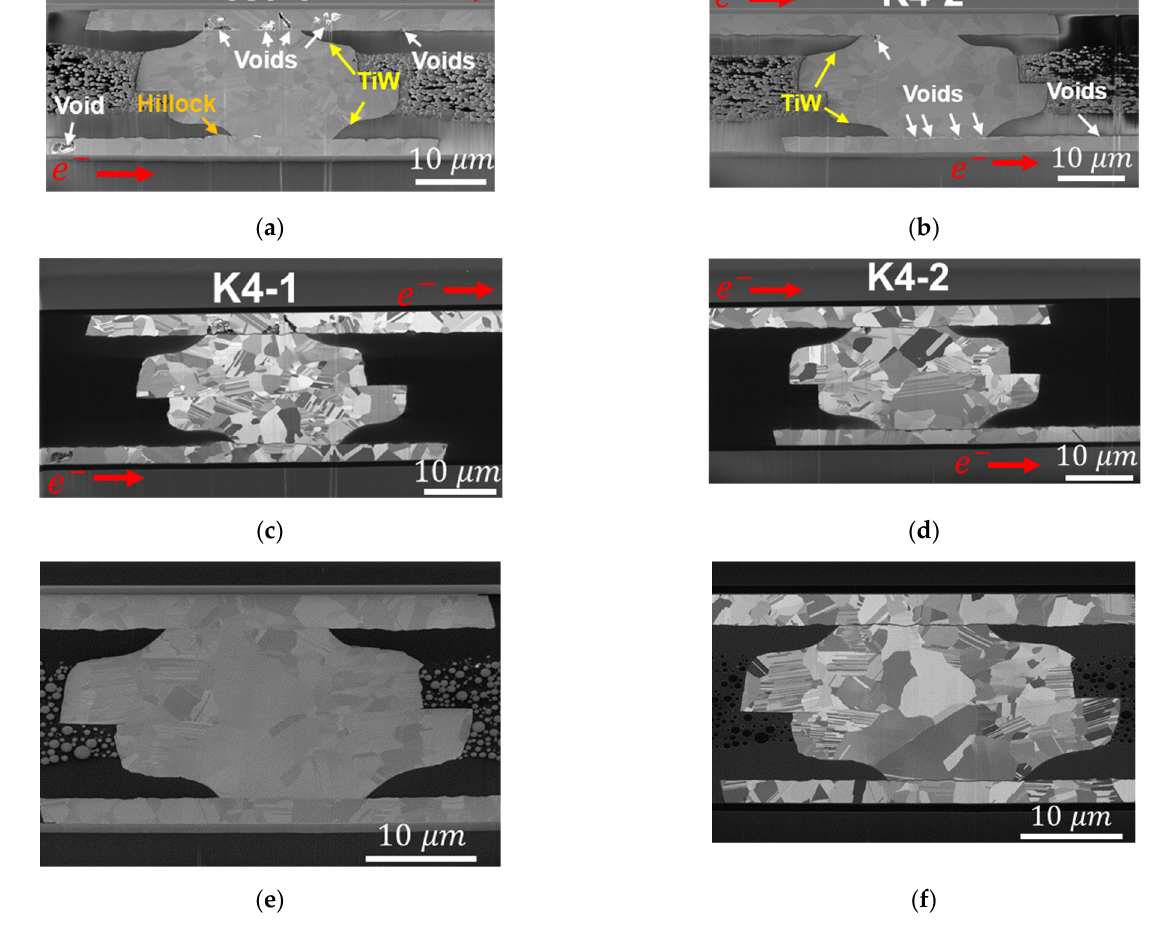
Figure 8. Destructive observation of 90 MPa/30 s_K4 bumps. ( a , b ) Electron images of K4-1 and K4-2 bumps, respectively. Voids are observed at the sites of current crowding. The voids are located at the side of electron current passing through the TiW layer. Additionally, voids form in RDLs far from Cu–Cu bumps. ( c , d ) Ion images of K4-1 and K4-2 bumps, respectively. The voids caused by EM are located along the grain boundary and TiW layer at the PSV opening. ( e , f ) Electron image and ion image of dummy bumps, respectively. No Cu oxide at the surface of Cu–Cu bumps and RDL appeared during EM test.